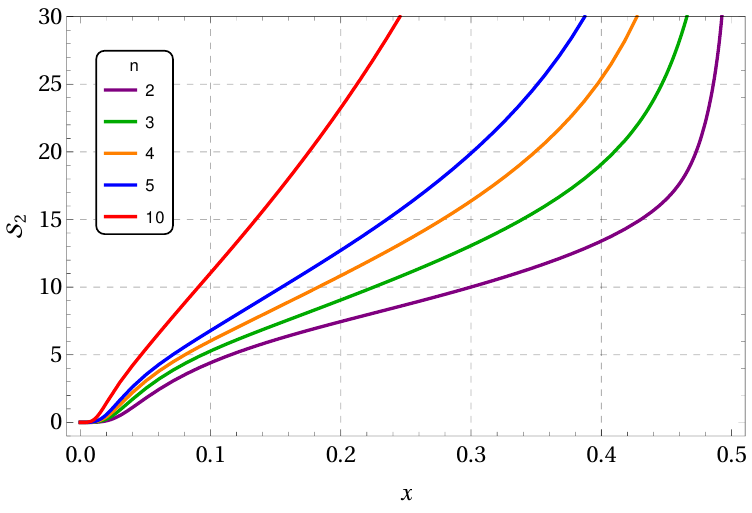
Figure 5 . The second Sandwiched Rényi Divergence for the states L − n | 0 i , n = 2 , 3 , 4 , 5 , 10 , at central charge c = 1 / 1000